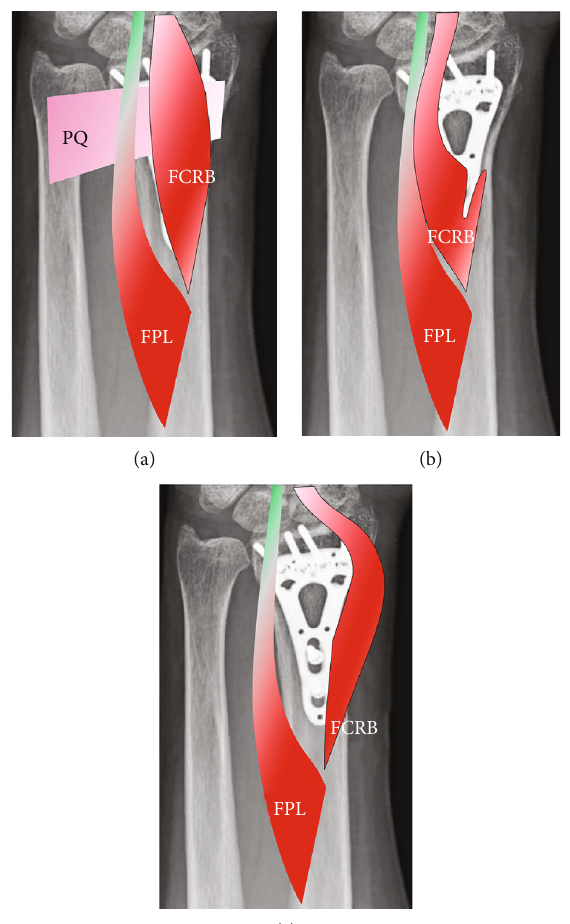
Figure 2: Illustration of the volar aspect of a distal forearm with a fl exor carpi radialis brevis (FCRB) muscle: (a) before exposure; (b) FCRB retracted ulnarly and partially detached from the radius; (c) FCRB retracted